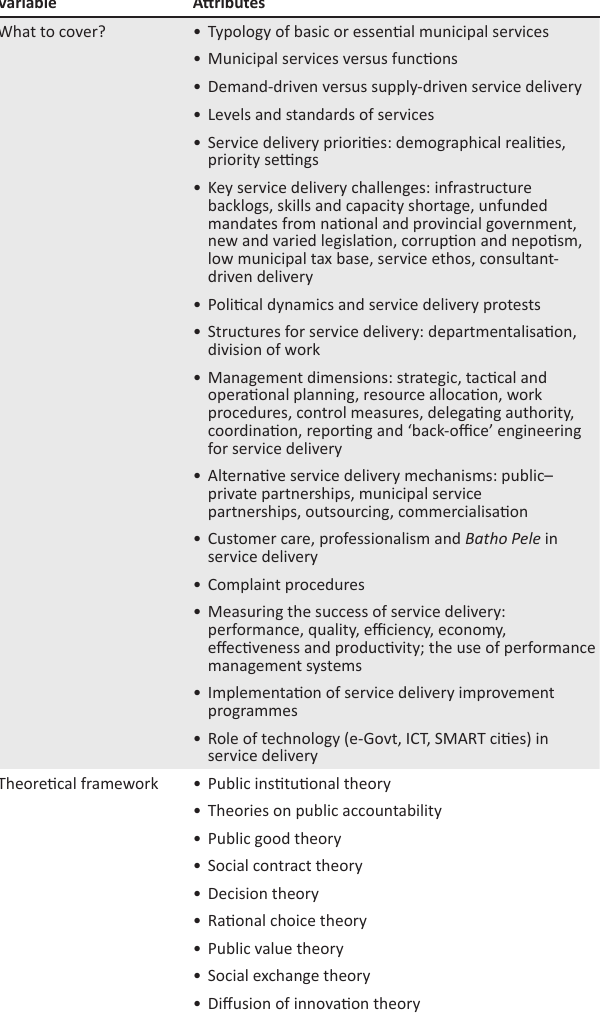
TABLE 3: Framing concept 3 – Service delivery.